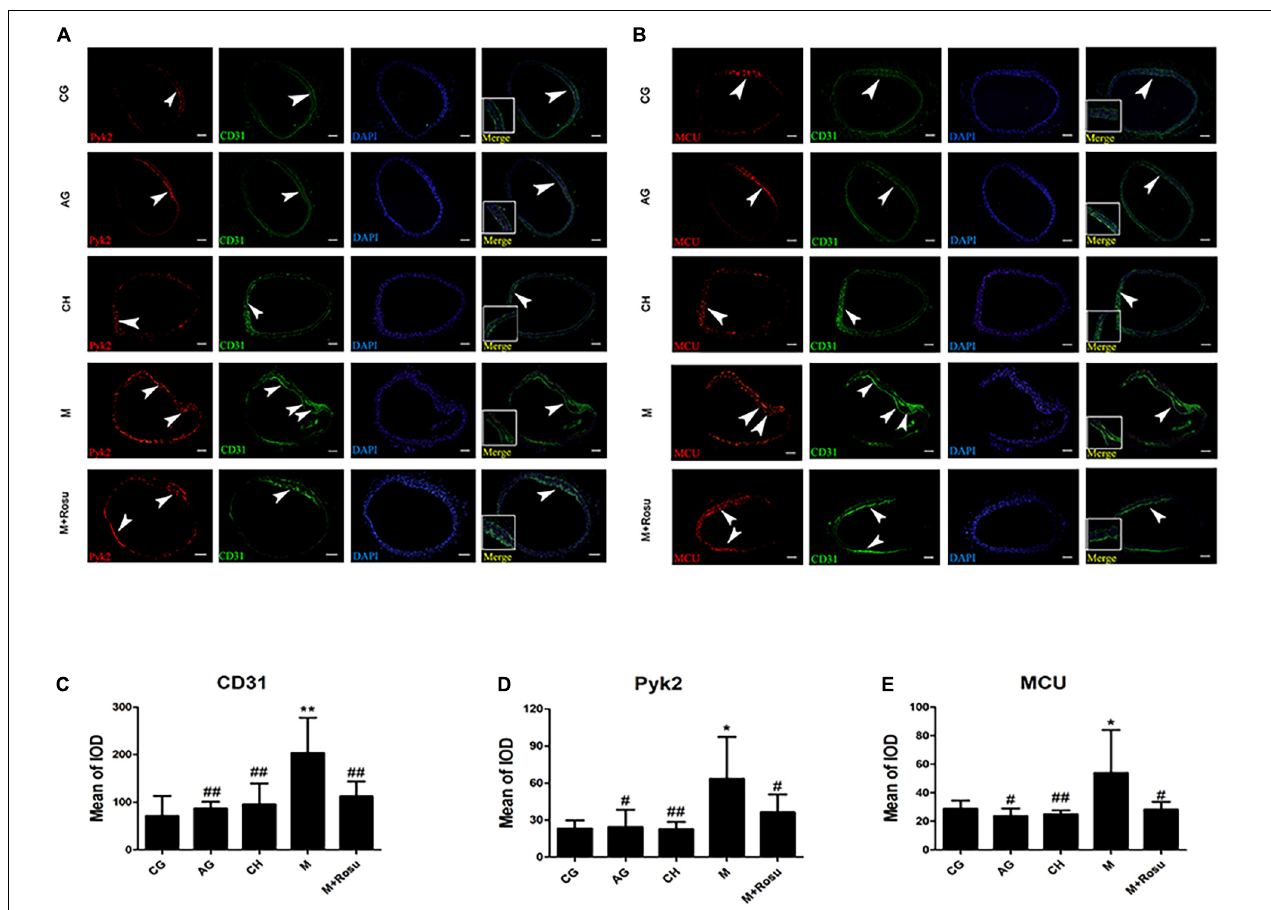
FIGURE 4 | The expression levels of Pyk2/mitochondrial calcium uniporter (MCU) after atherosclerosis in different groups by immunofluorescence. (A , B) Tissue immunofluorescence; arrowhead: the prominent position of the lesion in the intima. Scale bar: 100 µ m. (C–E) Mean of integrated option density of Pyk2, MCU, and caspase-3. Data are shown as mean ± SD of at least three independent experiments. * P < 0.05, ** P < 0.01 versus vehicle control (CG); # P < 0.05, ## P < 0.01 versus vehicle model (M); one-way ANOVA and Mann–Whitney nonparametric tests were applied to compare variables between two groups ( a = 0.05 as inspection level). CG, C57BL/6J+general diet; AG, ApoE – / – +general diet; CH, C57BL/6J+high-fat diet; M, ApoE – / – +high-fat diet; M+Rosu, ApoE – / – +high-fat